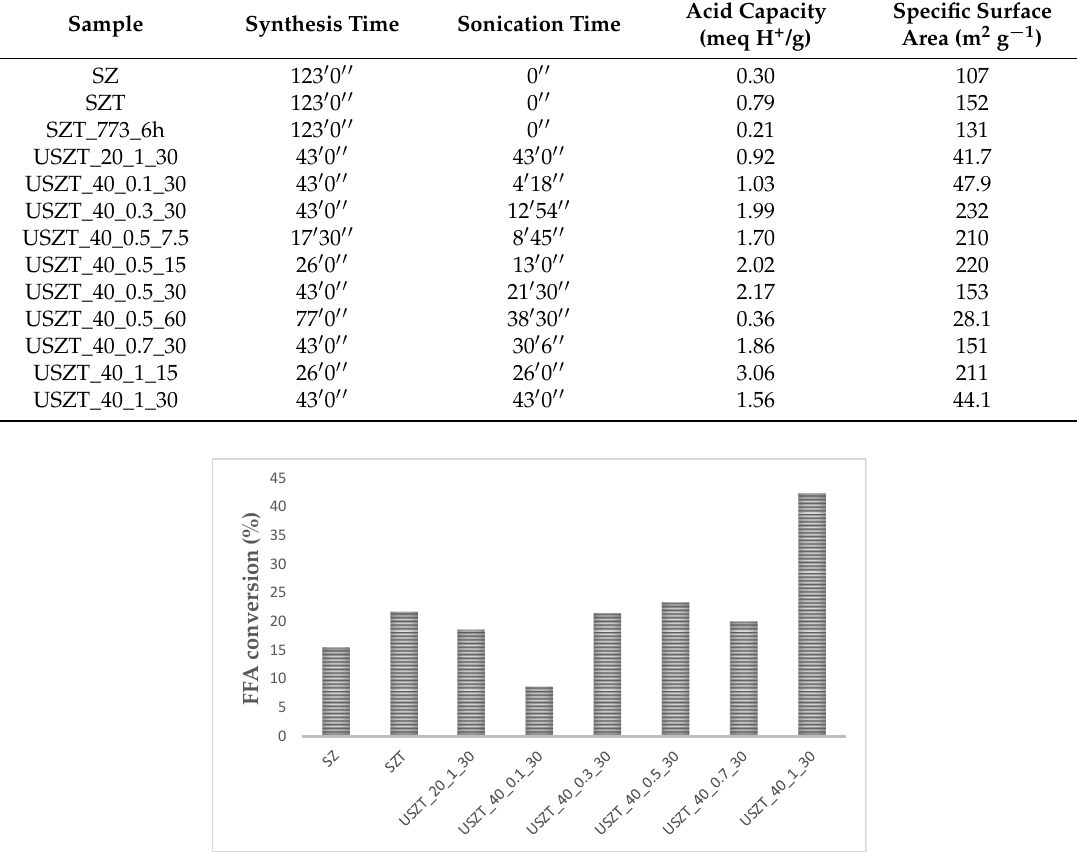
Table 5. List of all samples and of employed synthesis parameters (maximum power = 450 W).